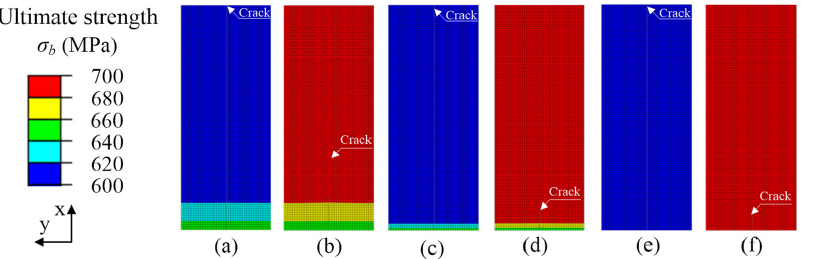
Figure 9. Crack propagation paths and ultimate strength distribution with mismatch coefficients in the x ‐ direction. ( a ) G x = − 50 MPa/mm, ( b ) G x = 50 MPa/mm, ( c ) G x = − 100 MPa/mm, ( d ) G x = 100 MPa/mm, ( e ) σ b,316L = 600 MPa, ( f ) σ b,304 = 700 MPa.